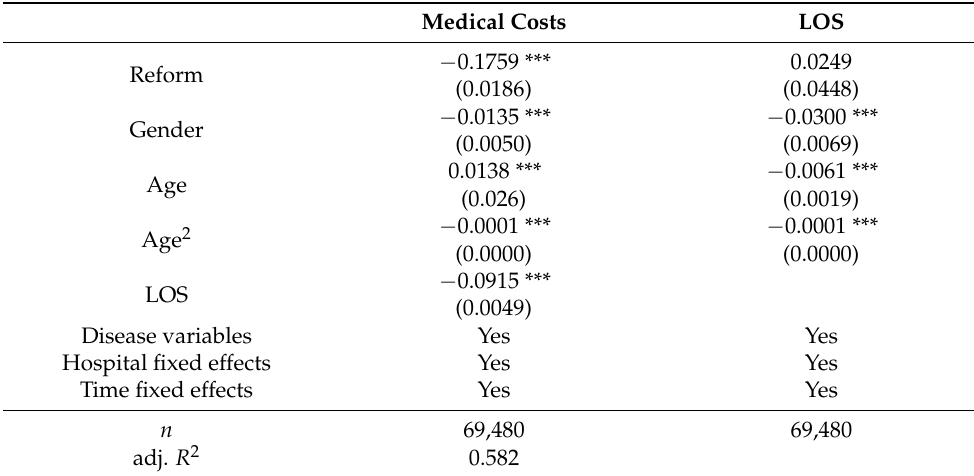
Table 2. Impacts of the per diem payment with inverted-U-shape